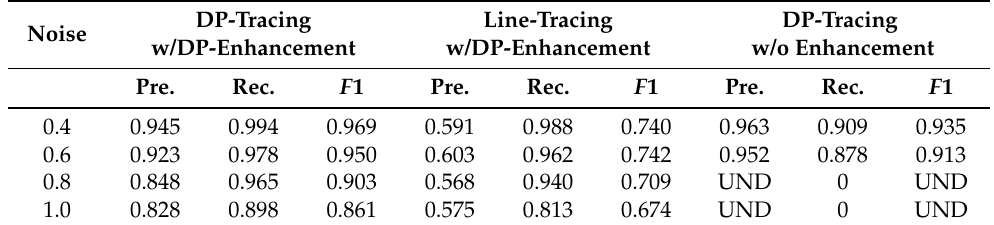
Table 1. A performance comparison of the proposed DP-based framework with the line-based approach for tracing actin filaments without density enhancement preprocessing at various levels of noise. UND = undefined because the FP and TP values are both zero. DP-Tracing Line-Tracing DP-Tracing Noise w/DP-Enhancement w/DP-Enhancement w/o Enhancement Pre. Rec. F 1 Pre. Rec. F 1 Pre. Rec.